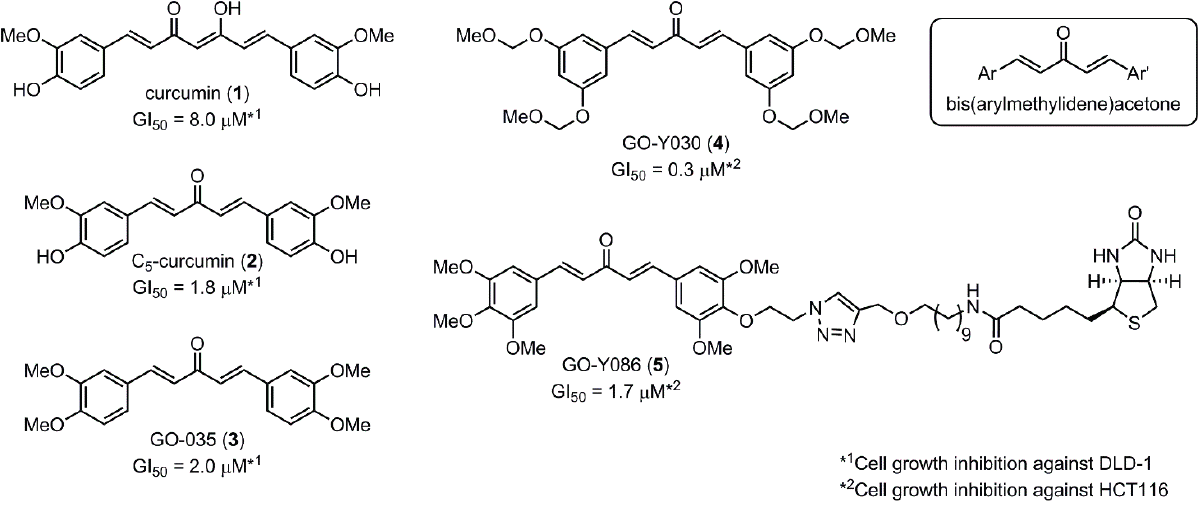
Figure 1. Structures of curcumin and C 5